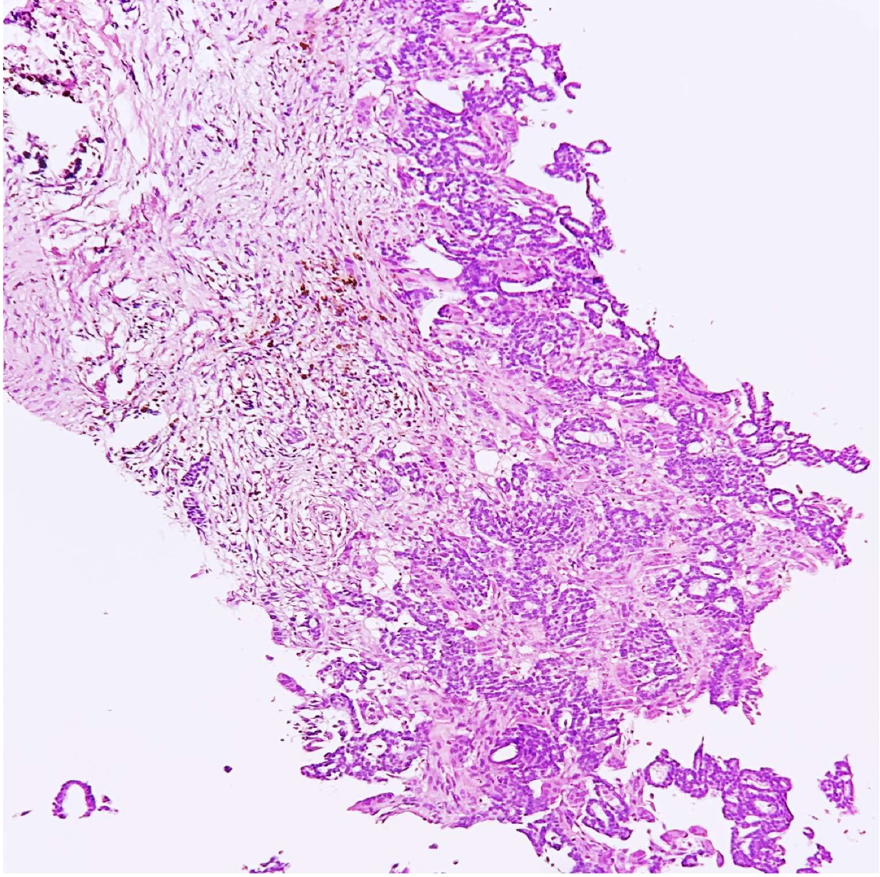
Figure 1. Ultrasound-guided core needle biopsy showing invasive breast carcinoma, associated with hemosiderin deposition (HE, 100×).